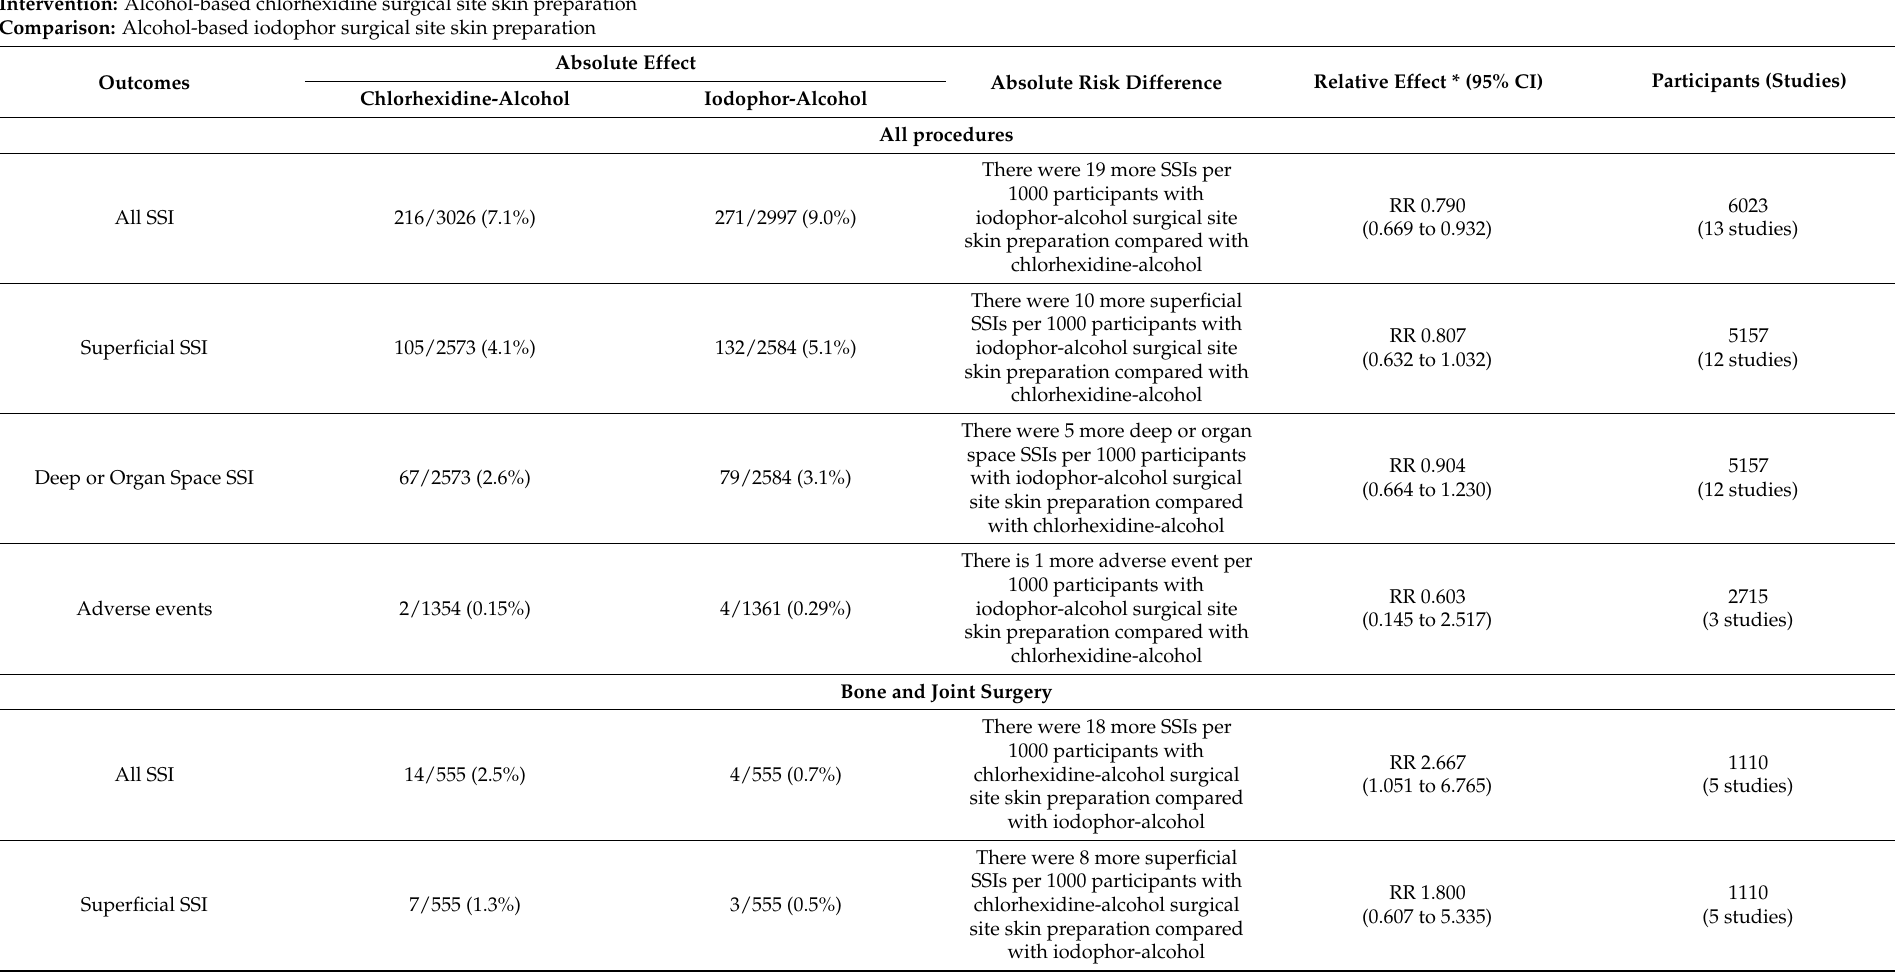
Table 2. Summary of Effects